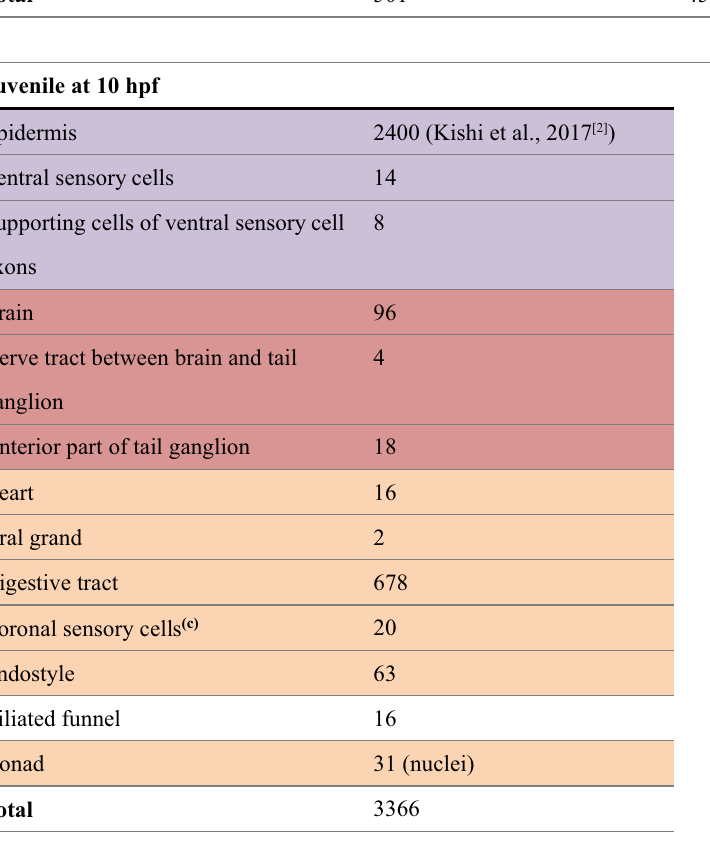
Table 1. Cell counts in the larva and juvenile. Different colors indicate possible progeny relationship between the larva and juvenile. a Cell numbers were counted using data of the present study. Cells were counted in the trunk region that is shown in Fig. 1D and Supplementary Movie S2 for the larva, and Fig. 2B,F and Supplementary Movie S7 for the juvenile. The larva is post-hatching larva. b Cell numbers in the whole body including the tail region were counted using the cell lineage tree in Stach et al. 6 . In this case, the larva is pre- hatching larva. Note that cell numbers of outer ectoderm cells and inner cells are much lower than those of post-hatching larva because these cells continue dividing during hatching time. c Coronal sensory cells are ciliated mechanosensory cells that are present in the oral region, and mediate ciliary reversal in the gills 3 . They are represented as green nuclei in the anterior region in Supplementary movie S7 and